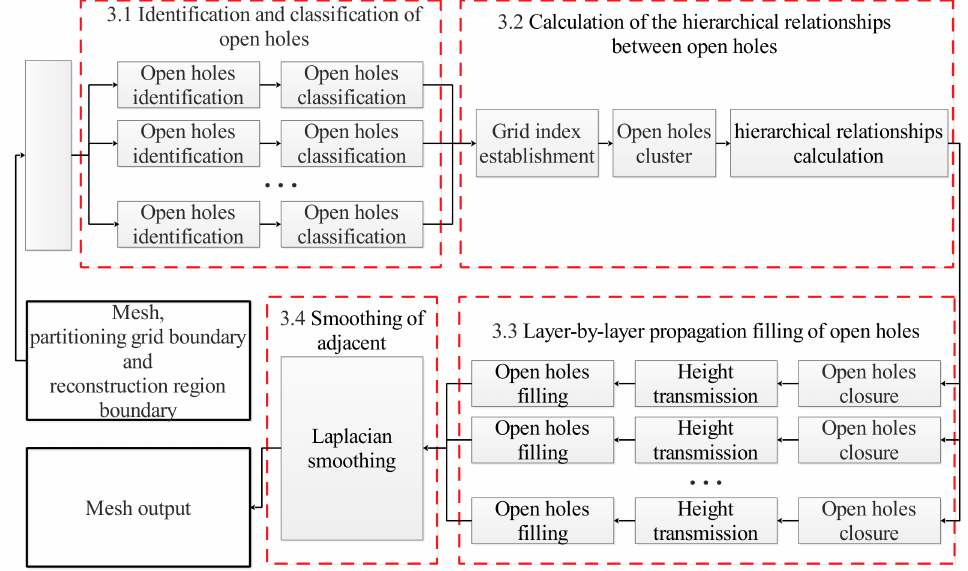
Figure 2. Flowchart of a parallel method for open hole